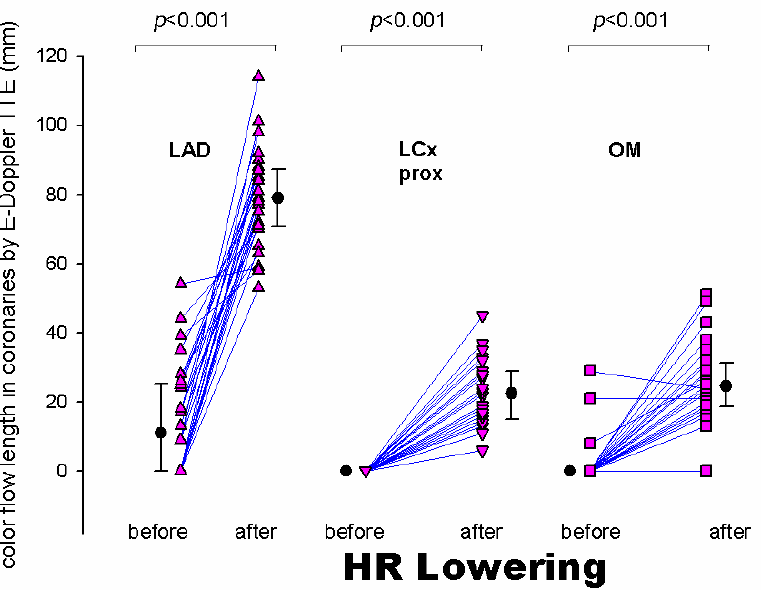
Figure 4. Individual value bar graph (and median [IQR]) of the color flow length measured in the whole LAD (triangles vertex up), proximal LCx (triangles vertex down) and the Obtuse Marginal (squares) before and after HR lowering. The length of the artery explored by E-Doppler TTE in terms of color flow is enormously and significantly expanded after HR lowering. LAD = left anterior descending coronary artery; LCx = left circumflex coronary artery; prox = proximal; OM = obtuse marginal branch of the LCx; HR = heart rate; IQR = interquartile range.